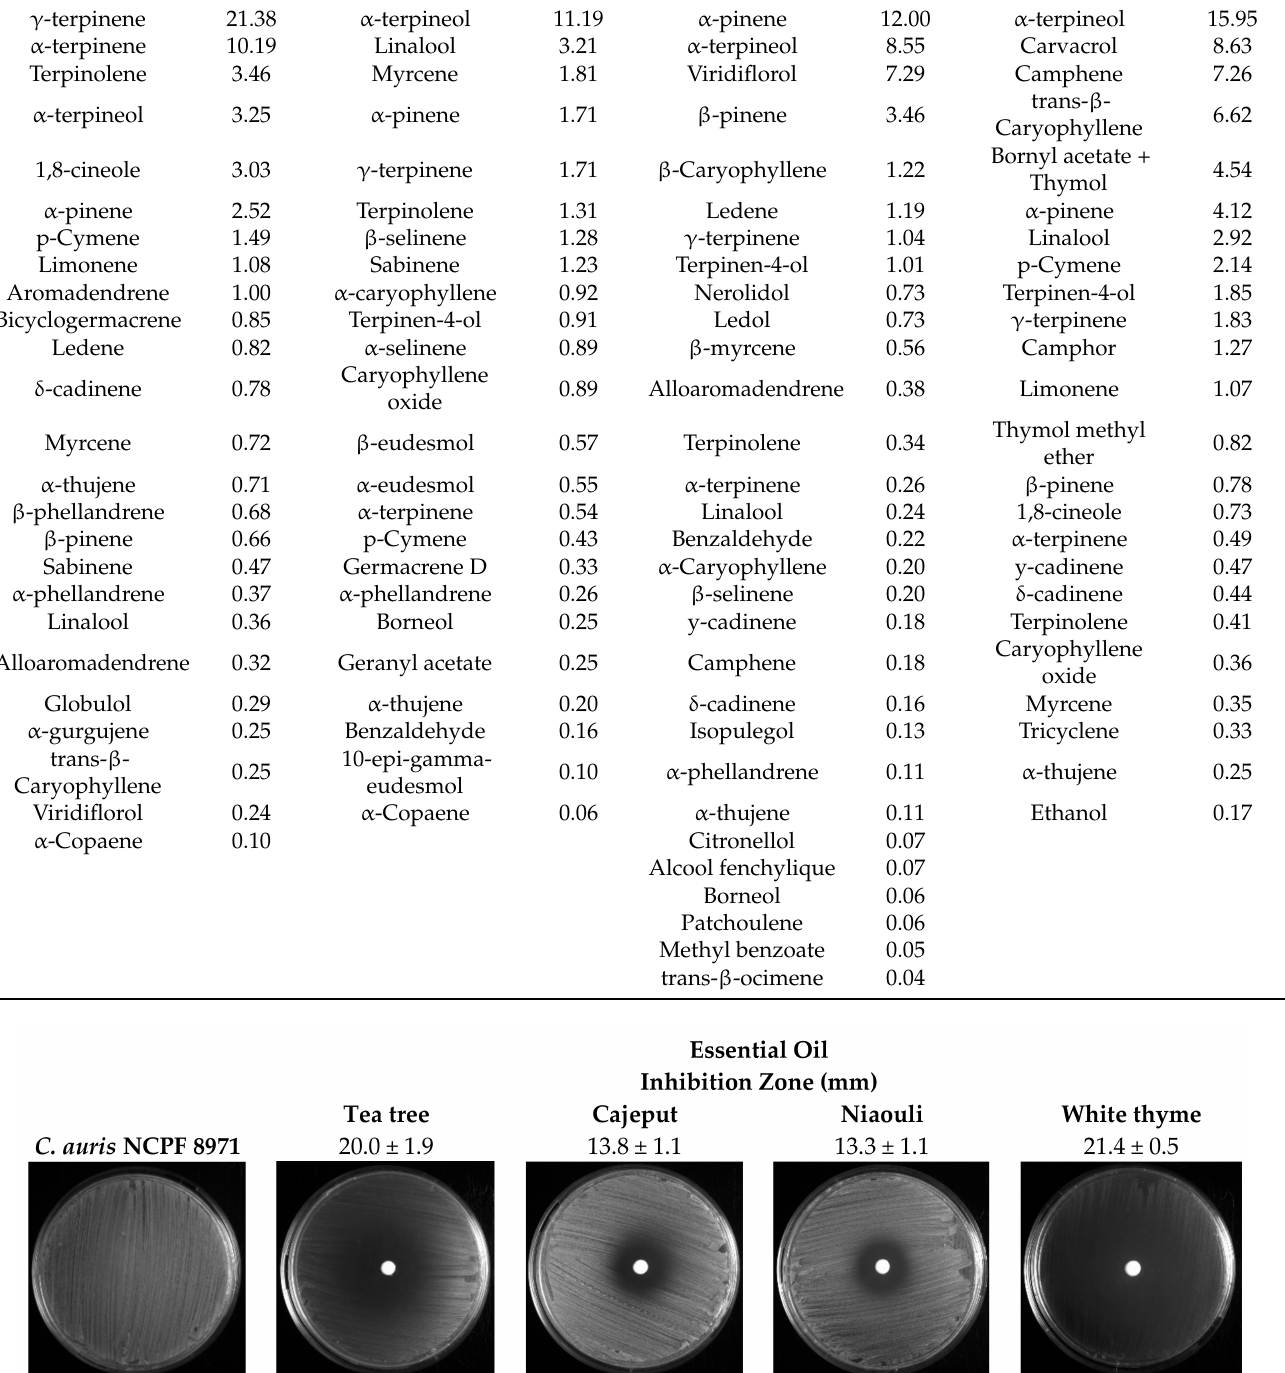
Figure 1. Antifungal activity of essential oils on C. auris NCPF 8971 evaluated using the disk diffusion